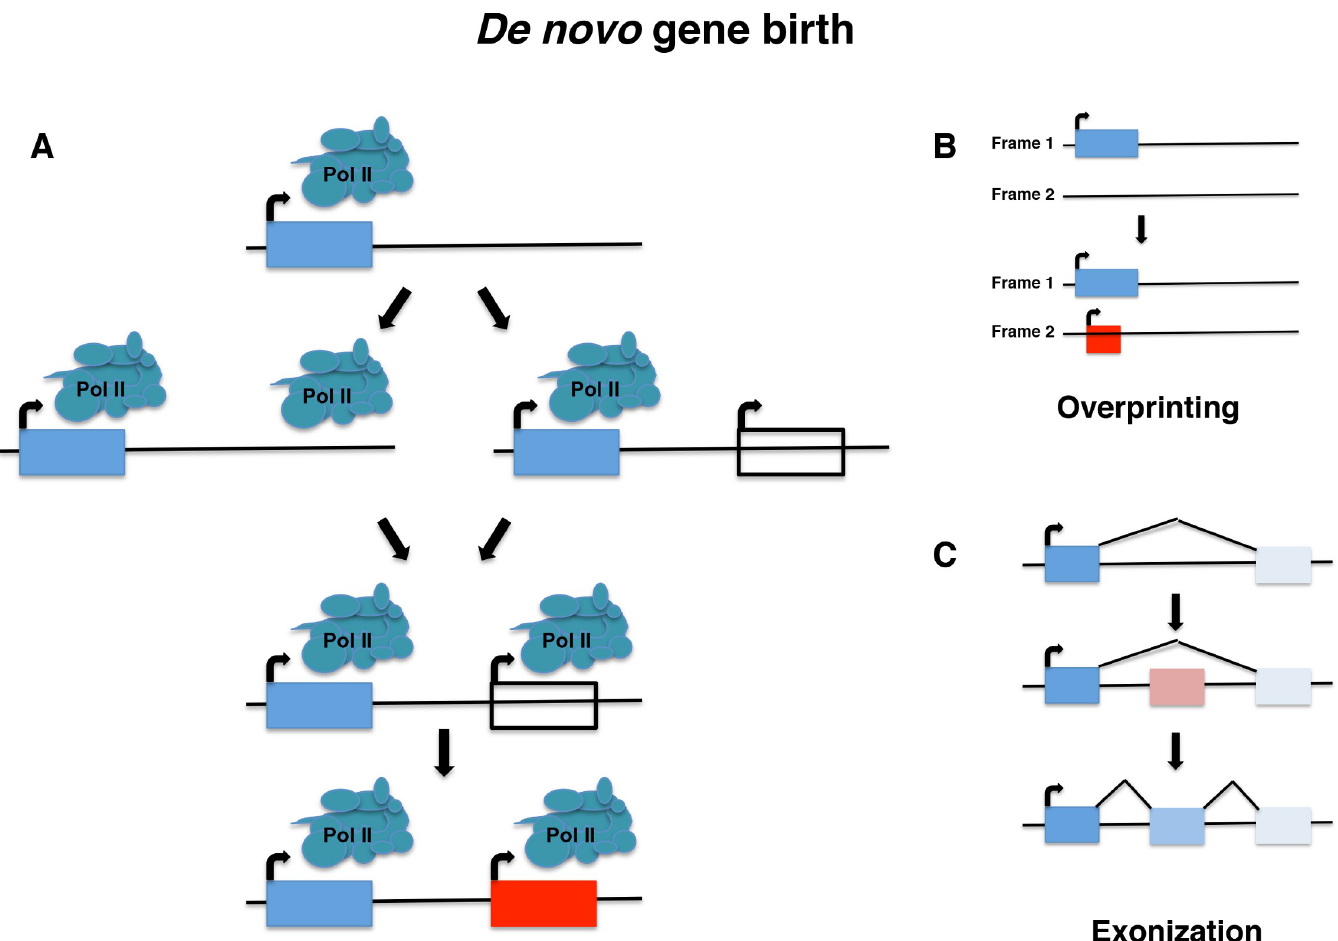
Fig 1. De novo gene birth. Novel genes can emerge from ancestrally non-genic regions through poorly understood mechanisms. (A) A non-genic region first gains transcription and an ORF, in either order, facilitating the birth of a de novo gene. The ORF is for illustrative purposes only, as de novo genes may also be multi-exonic, or lack an ORF, as with RNA genes. (B) Overprinting. A novel ORF is created that overlaps with an existing ORF, but in a different frame. (C) Exonization. A formerly intronic region becomes alternatively spliced as an exon, such as when repetitive sequences are acquired through retroposition and new splice sites are created through mutational processes. Overprinting and exonization may be considered as special cases of de novo gene